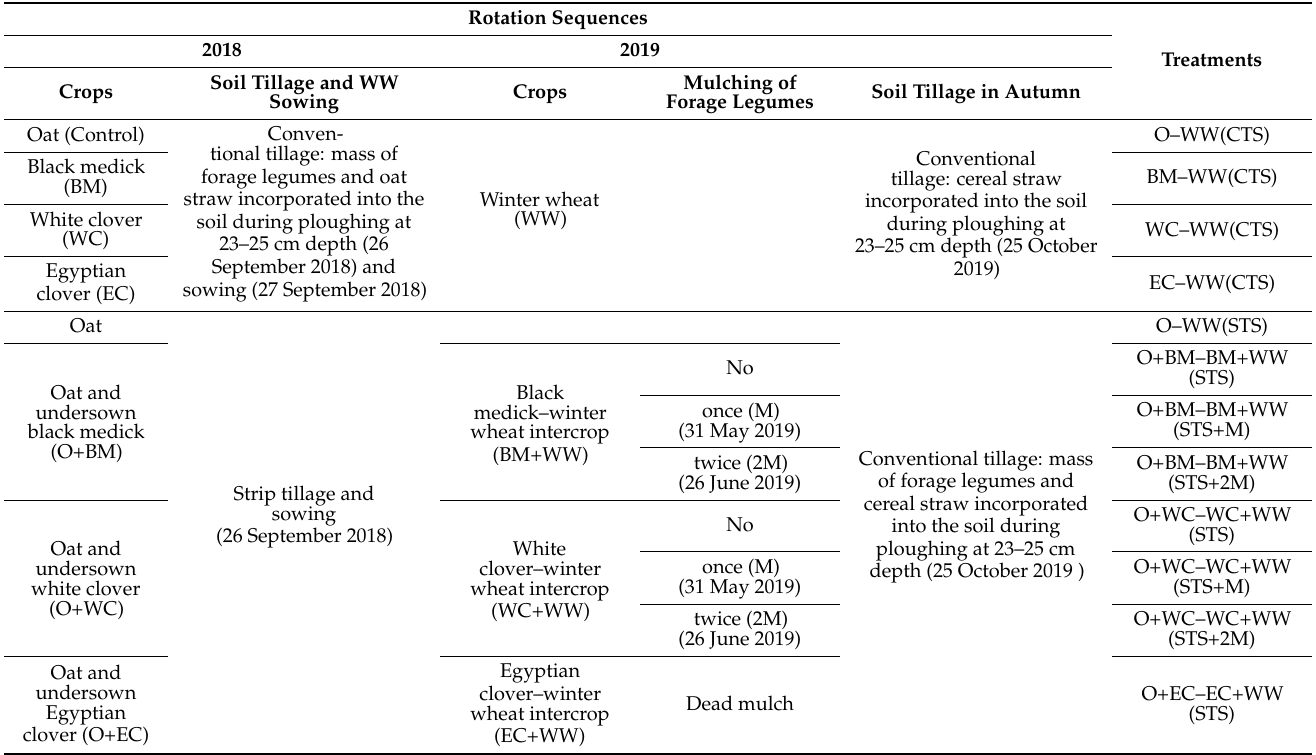
Table 1. Crops, tillage, and sowing